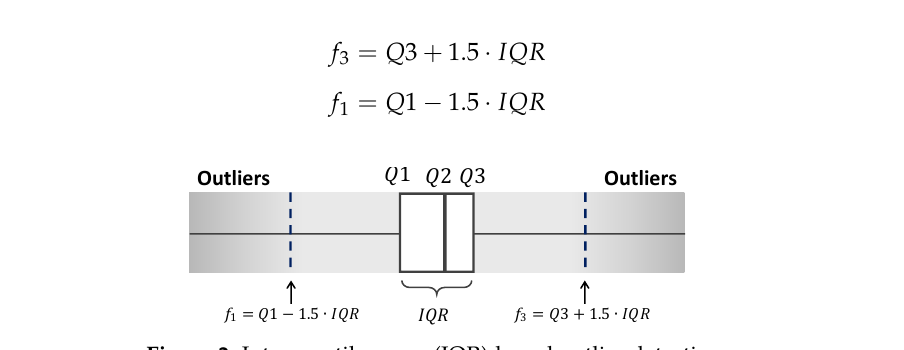
Figure 2. Interquartile range (IQR)-based outlier detection.